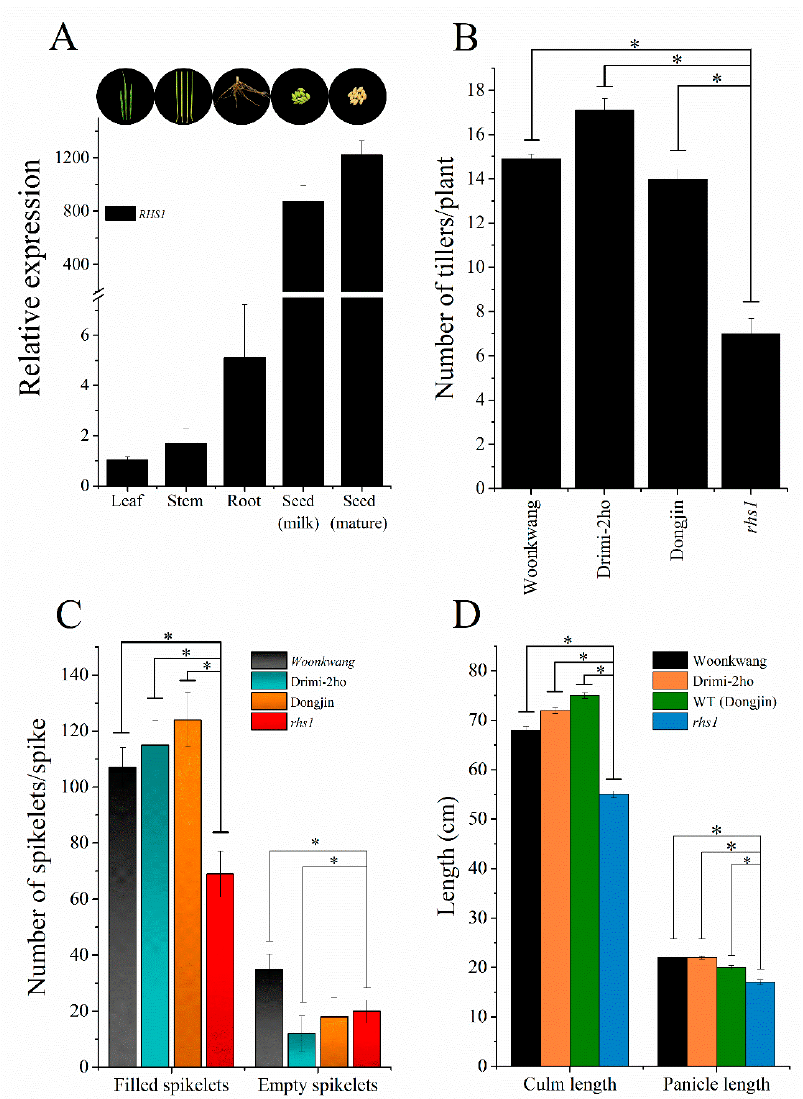
Figure 4. RHS1 is expressed in seeds and regulates plant development. The expression of RHS1 (LOC_Os04g41250) was highest in mature seeds, followed by milk-stage seeds and roots ( A ). The loss of the RHS1 function negatively affected the overall yield and plant development as the rhs1 plants produced a smaller number of tillers per plant ( B ), a smaller number of spikelets per spike ( C ), and showed a stunted phenotype ( D ). Each data point represents the mean of three replications. Means were analyzed for significant difference using the Student’s t -test. Error bars represent the standard deviation. Significant differences are represented by asterisk (*) at p < 0.05.